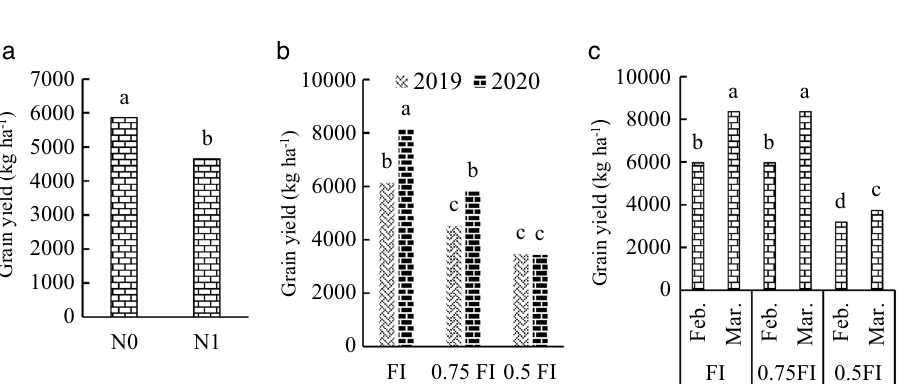
Figure 1. The effect of nitrogen fertilizer averaged over irrigation and sowing date ( a ), irrigation averaged over nitrogen and sowing date ( b ), and irrigation × sowing date interaction ( c ) on grain yield (kg ha −1 ) in pea. FI: full irrigation, N: nitrogen, Feb: February, Mar: March. Means with different letters did differ